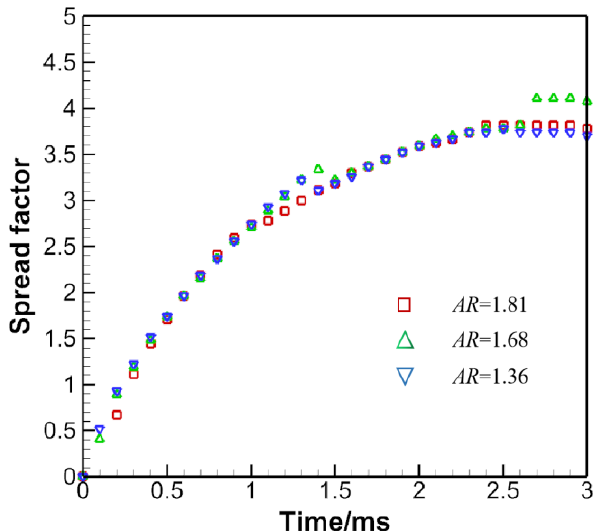
Figure 19. Spread factor evolution for the prolate droplet impact.